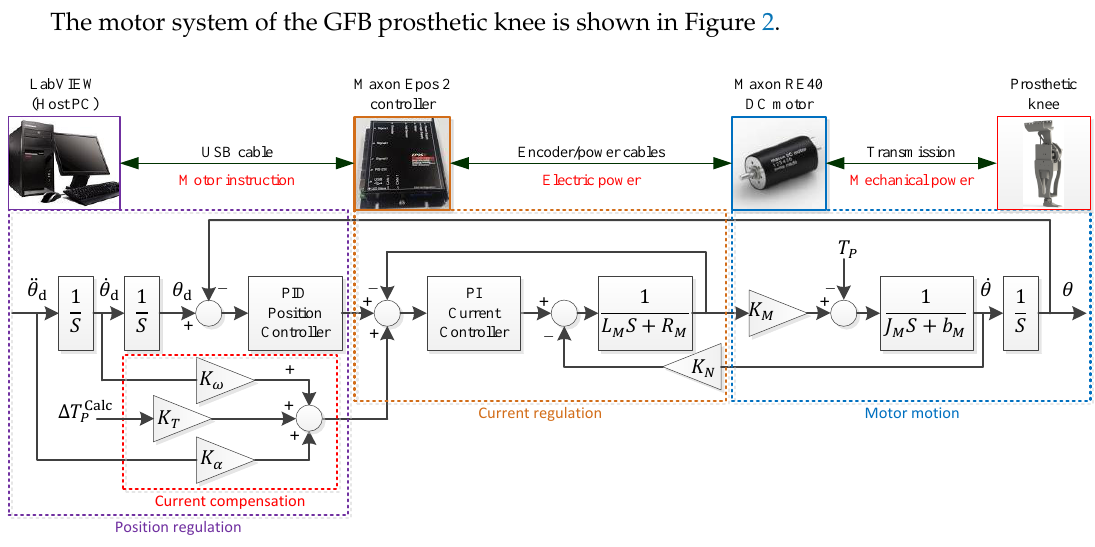
Figure 2. Motor control system (feedforward current compensations are provided to deal with inertial-related, speed-related and load-related changes in the prosthetic system). L m and R m are the inductor and the resistor of the motor, and J m and b m are the moment of inertial and damping of the motor and transmissions; K M and K N are the torque constant and the speed constant of the motor, respectively; K ω , K τ and K α are corresponding gains of feedforward current compensations; T p is the needed actuating torque of the prosthetic knee, and ∆ T Calc is the calculated prosthetic torque changes by real-time inverse dynamics of the prosthetic knee.